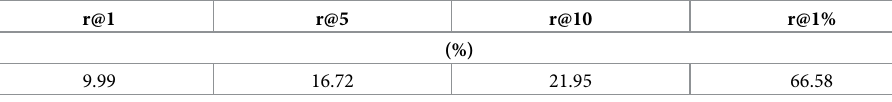
Table 6. r@ k metrics of EgoTR fine-tuned over the reshaped BDD-trajectories dataset. r@1